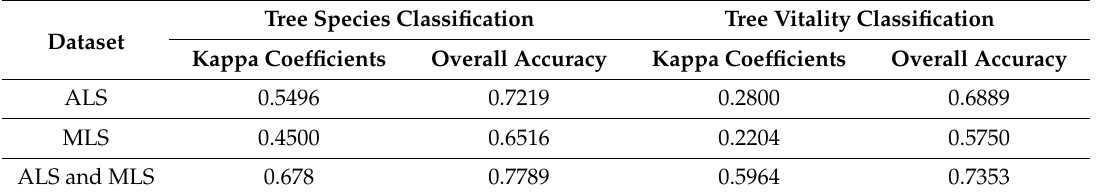
Table 11. Overall accuracy for tree species and vitality